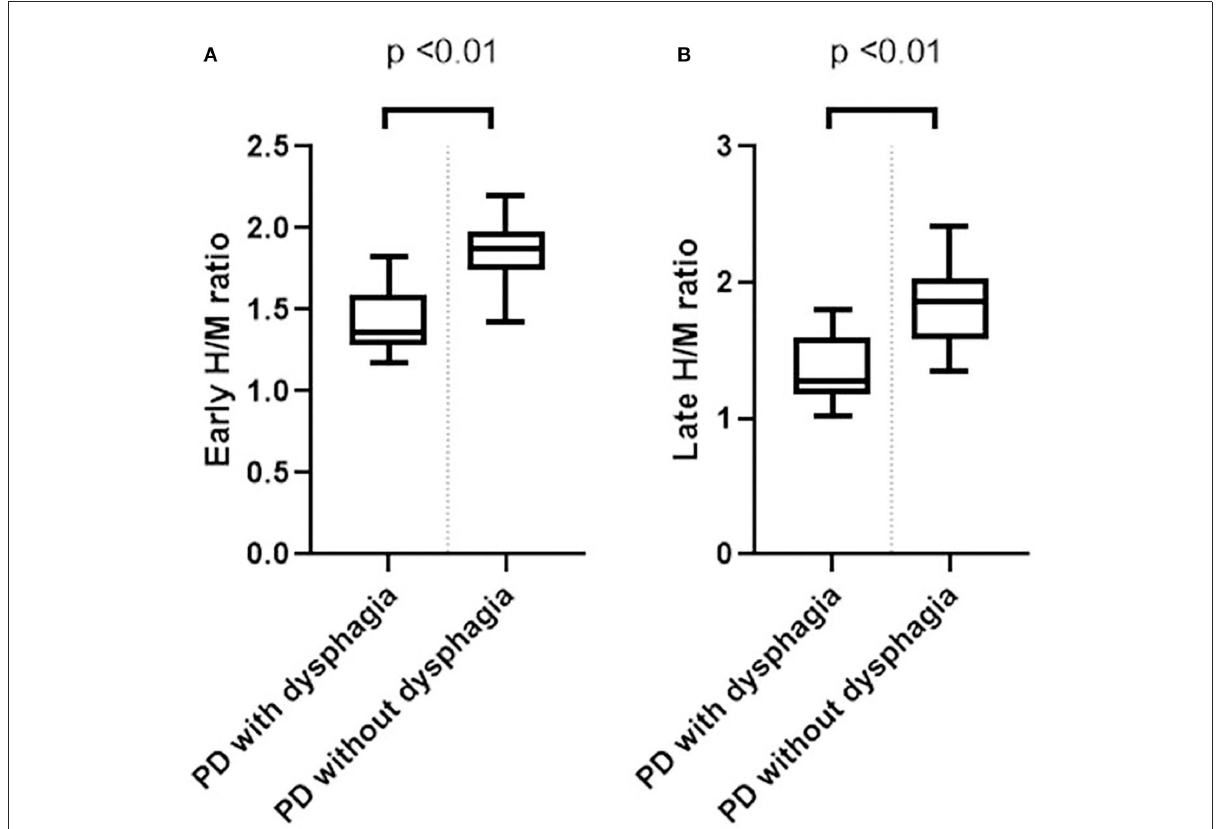
FIGURE1 Box plots of the early (A) and late (B) H/M ratios between the PD with dysphagia and PD without dysphagia